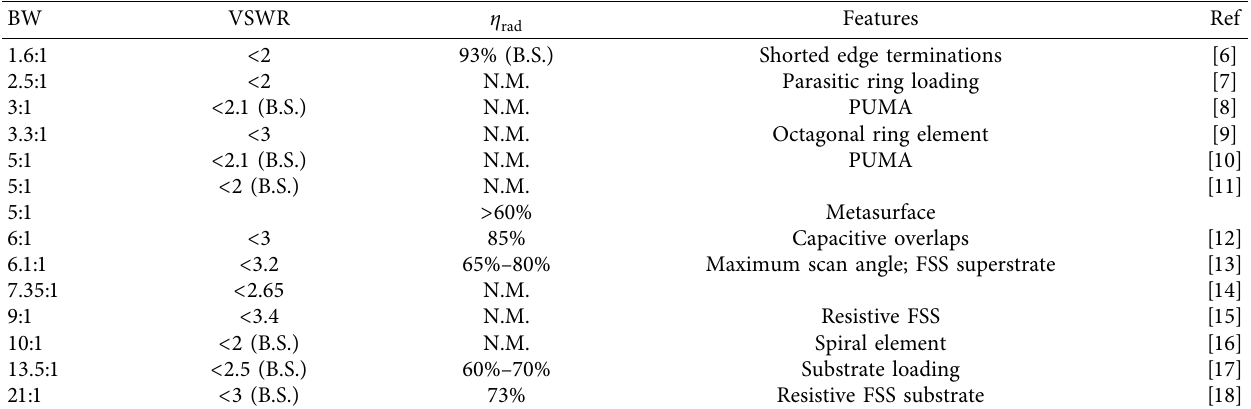
Table 1: State of the art of